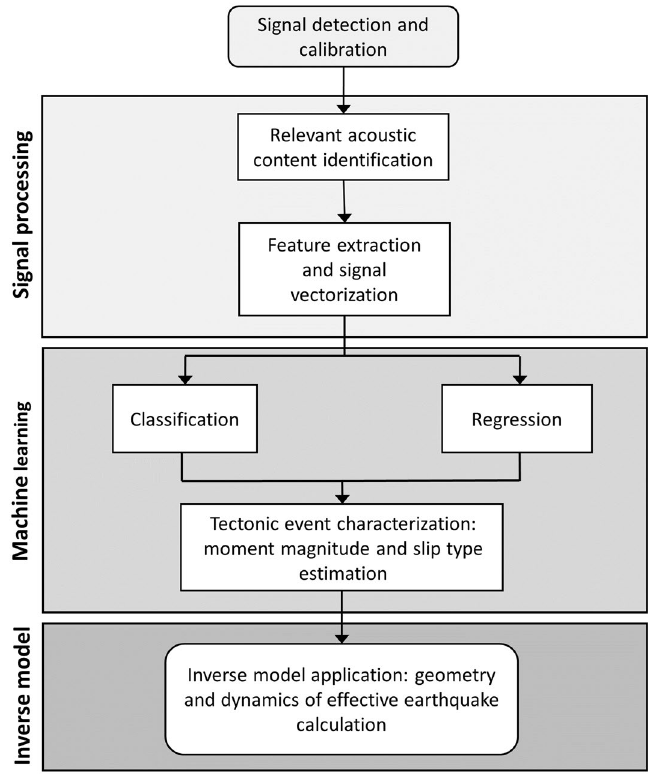
Figure 1. Flow chart for the methodology of tectonic event characterization from acoustic recordings